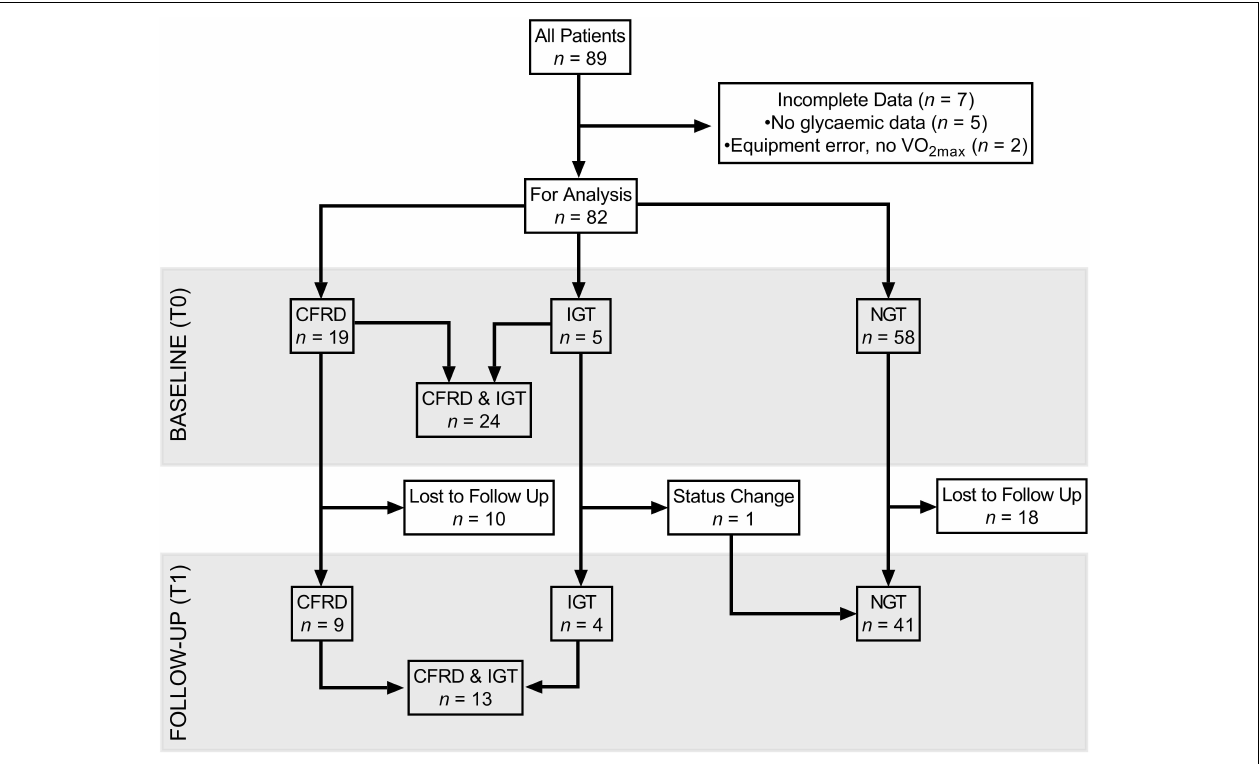
FIGURE 1 | Flow diagram, characterising follow-up and drop-out of participants, split by glycaemic status in three groups (CFRD, IGT, NGT), and when considered dichotomously (IGT/CFRD, NGT) at baseline and one-year follow-up. CFRD: cystic fibrosis related diabetes; IGT: impaired glucose tolerance; NGT: normal glucose tolerance; T0: baseline measurement; T1: 1 year follow-up; VO 2max : maximal oxygen